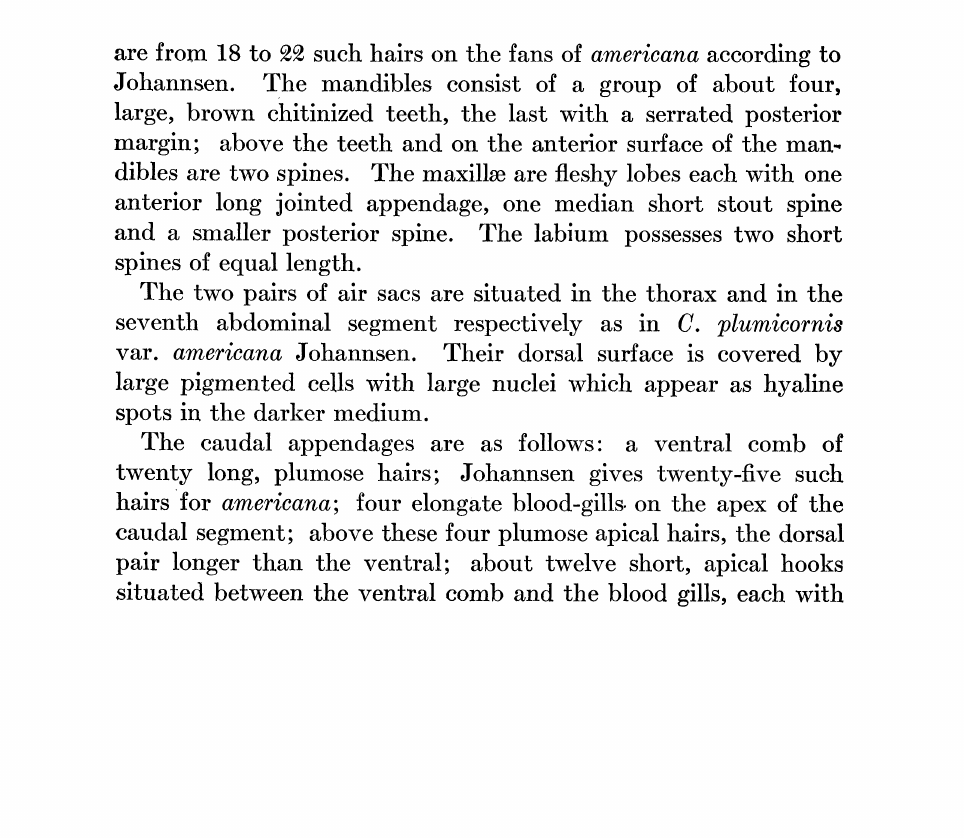
Fig. 1. Antennae oi Corethra albipes